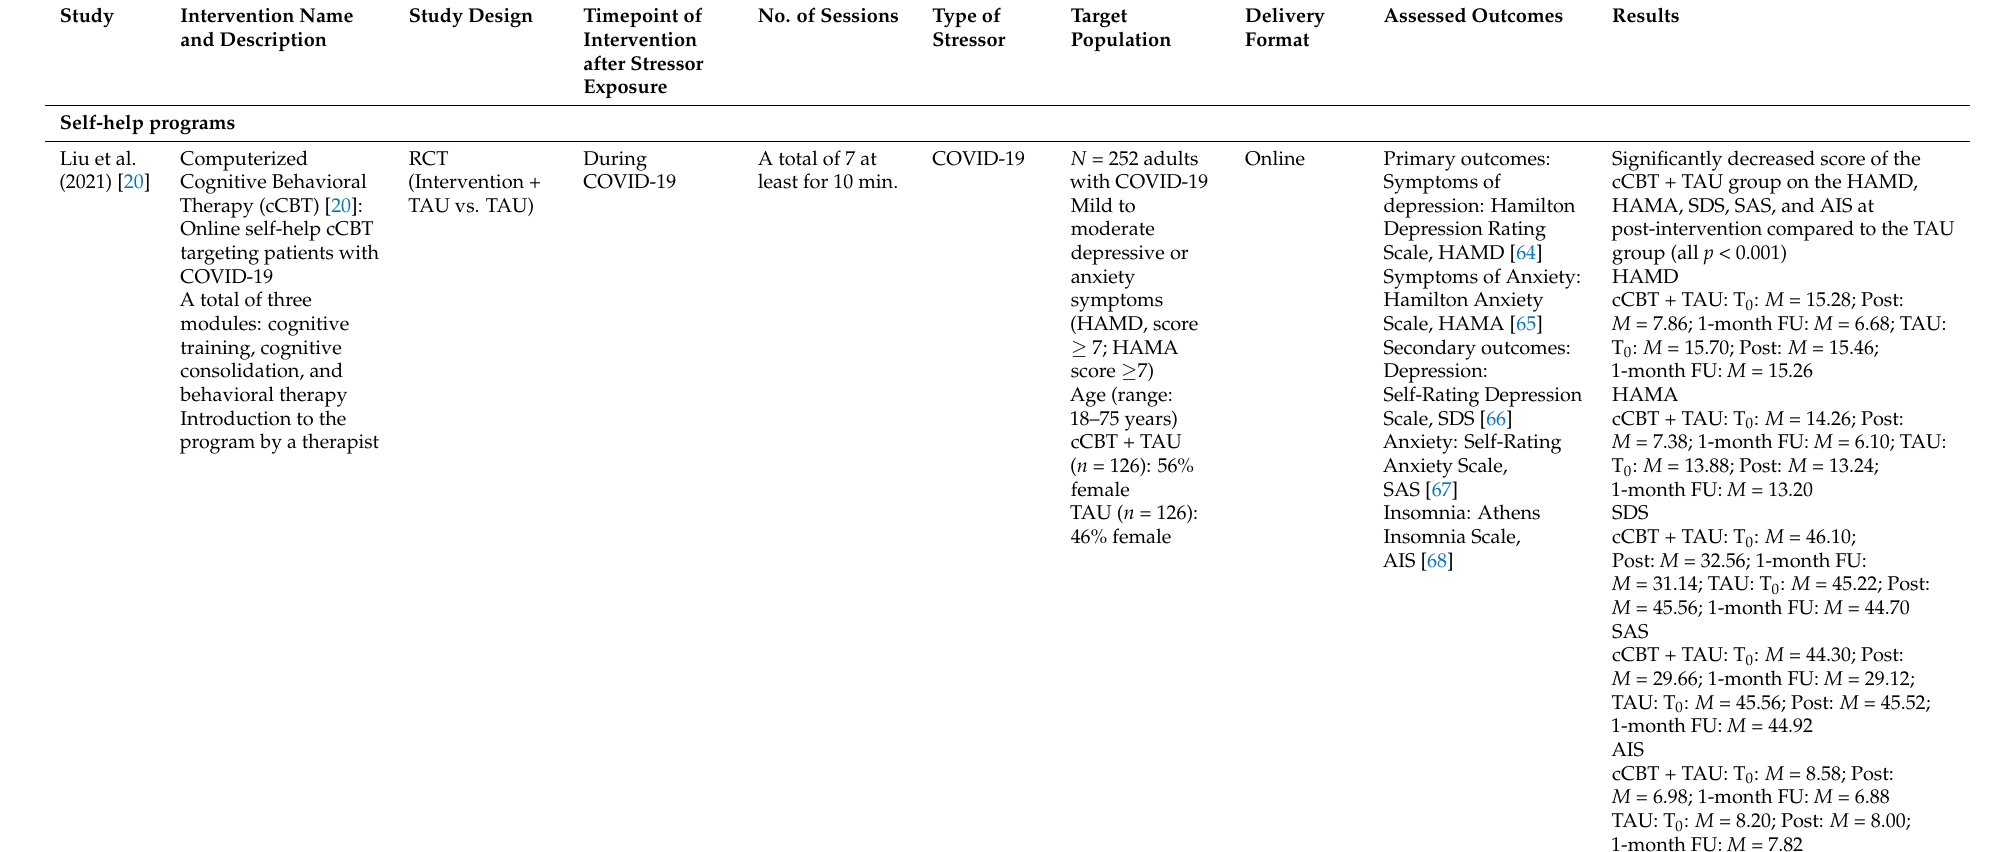
Table A2. Detailed overview of intervention characteristics and results of the included studies/protocols ( n =